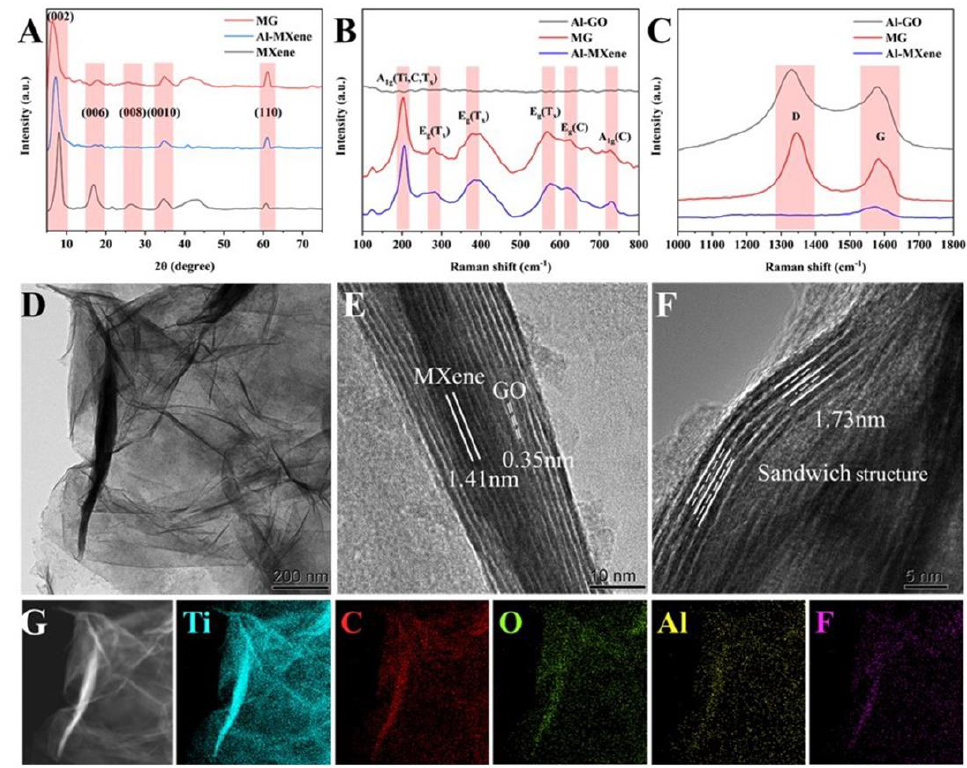
Figure 1. Successful synthesis of MG. ( A ) XRD, ( B , C ) Raman, ( D ) TEM, ( E , F ) HR − TEM, and ( G ) EDS. Thus, MG’s formation process and mechanism are presumed as follows (Figure